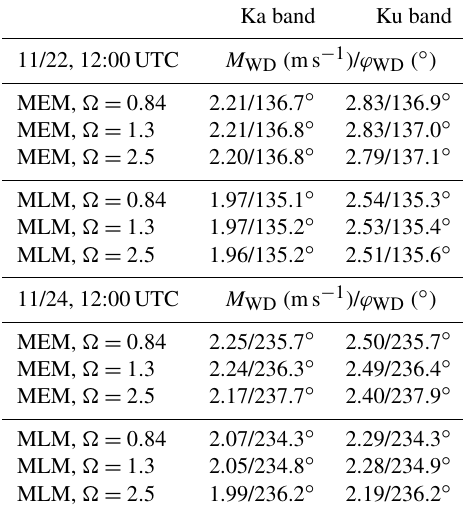
Table 4. Modeled wave Doppler velocity amplitude M WD and di- rection ϕ WD at the Ku and Ka band with directional wave spec- tra produced using the maximum entropy or maximum likelihood methods and varying the wave age parameter (cid:127) of the Elfouhaily (1997) high-frequency spectral tail. In all cases the transition fre- quency between the wave data and the high-frequency spectrum is f t = 0 . 35Hz. All values are estimated for θ = 12 ◦